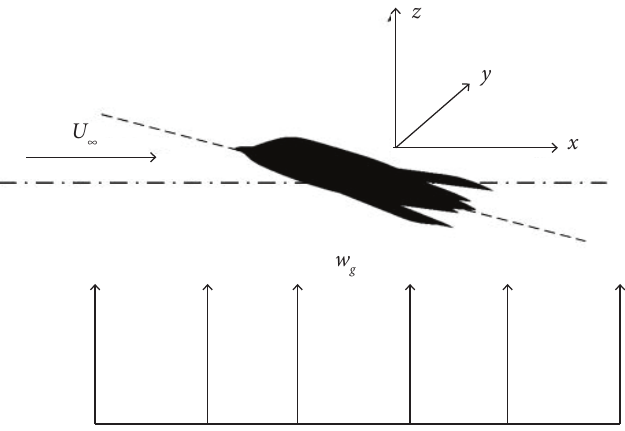
Figure 1. Sketch of gust leading a step change in the angle of